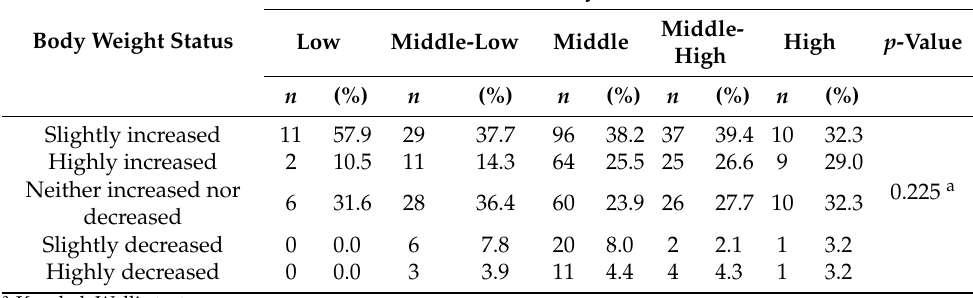
Table 5. Comparison of the body weight status and the family income for the past 6 months during the pandemic.